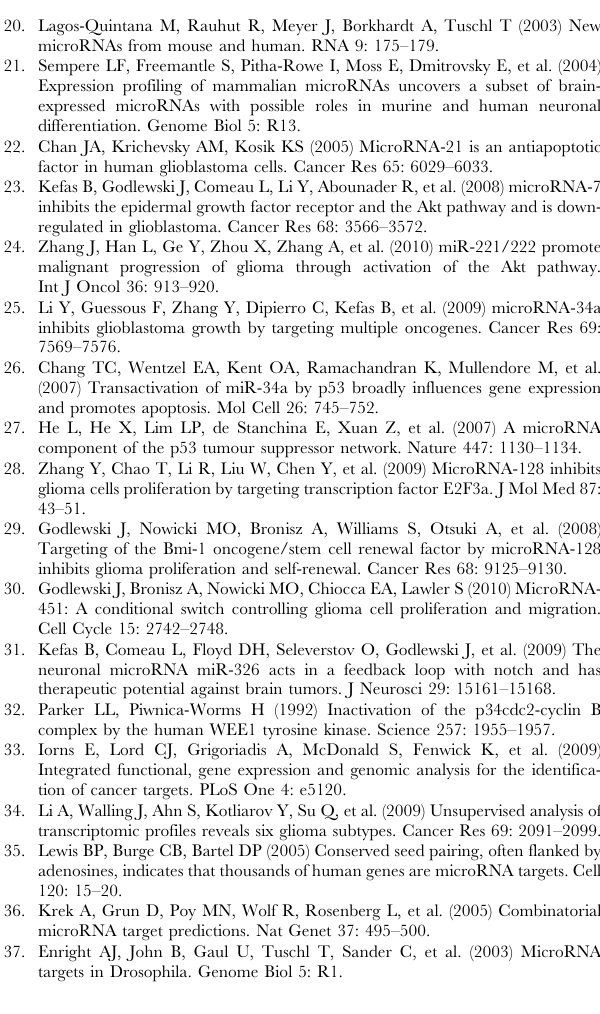
Table S1 List of 462 miRs and their lg 2 -fold change of expression in 27 GBM and 11 non-tumor samples.